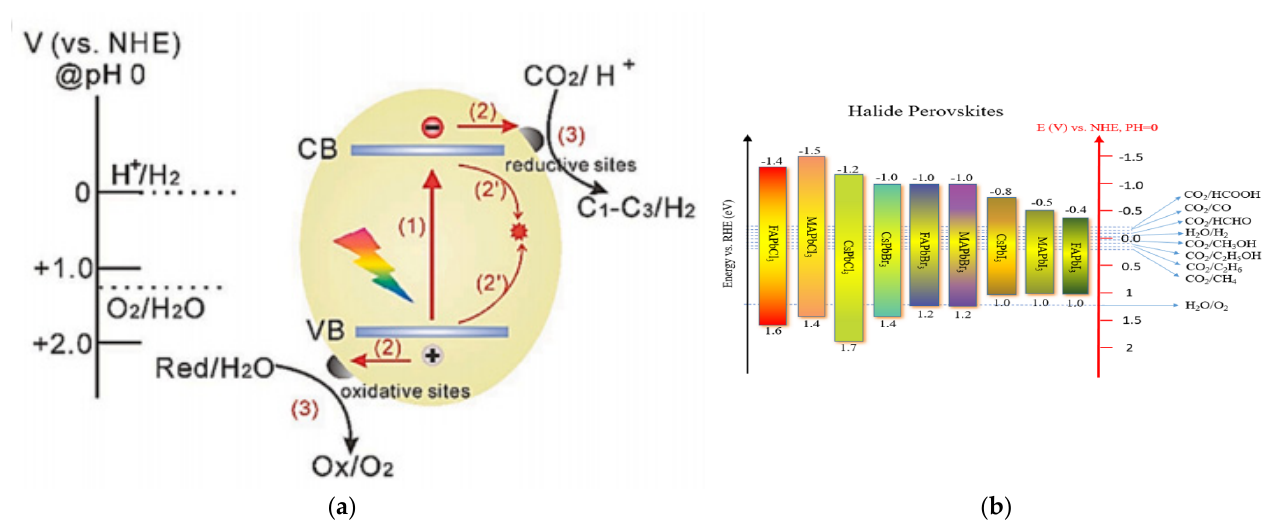
Figure 2. ( a ) Schematic illustration of charge transfer reactions that may occur at the surface and in the bulk of a semiconductor photocatalyst. ( b ) Energy levels of halide perovskites with the relative potential in photocatalytic applications. ( a ) Reproduced with permission [88]. Copyright: 2020, Wiley.